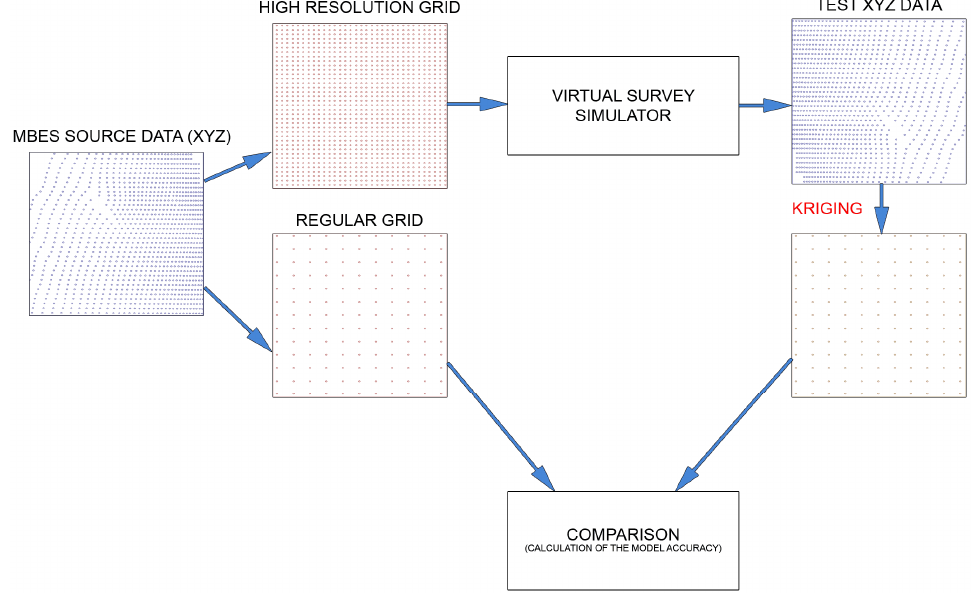
Figure 2. Workflow of the research procedure using virtual survey simulator. MBES: multibeam echosounder device.